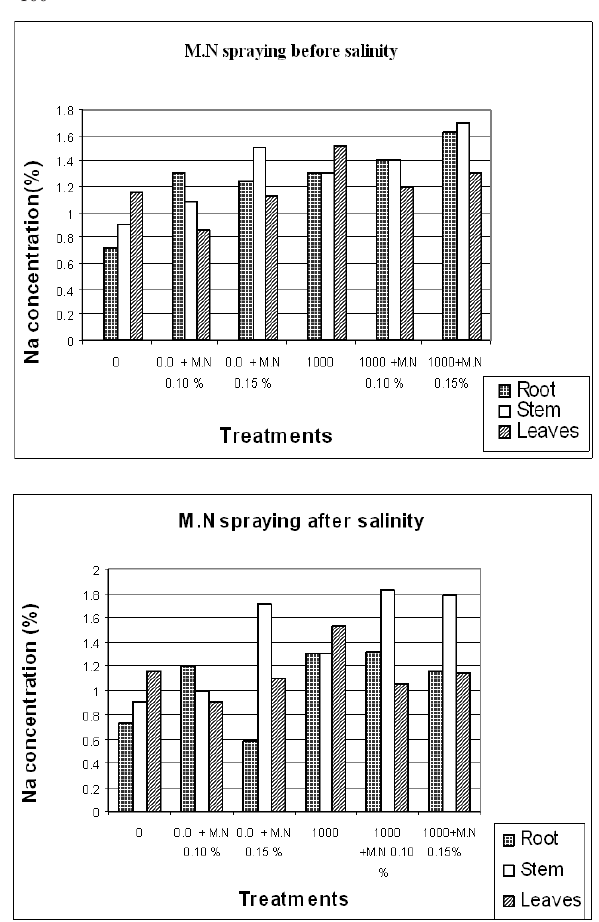
Fig. 2. Effect of spraying micronutrients before and after salinity treatments on Na+ concentration (%) of faba bean plant; 0= without salinity; 1000=1000ppm NaCl;